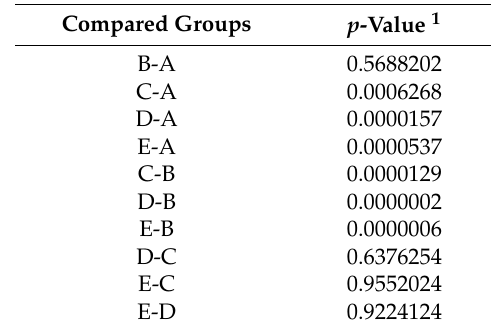
Table A9. This table shows the p -values between the indicated groups from the data used for Figure 3E and the data displayed in Table A6.